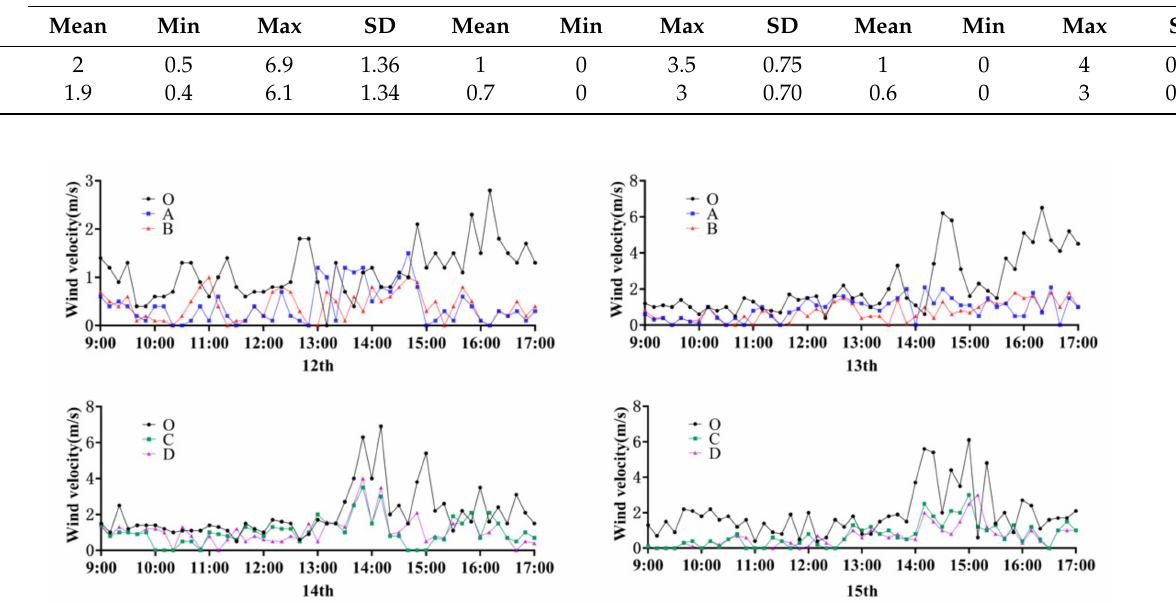
Figure 9. Comparison of wind speed changes in different